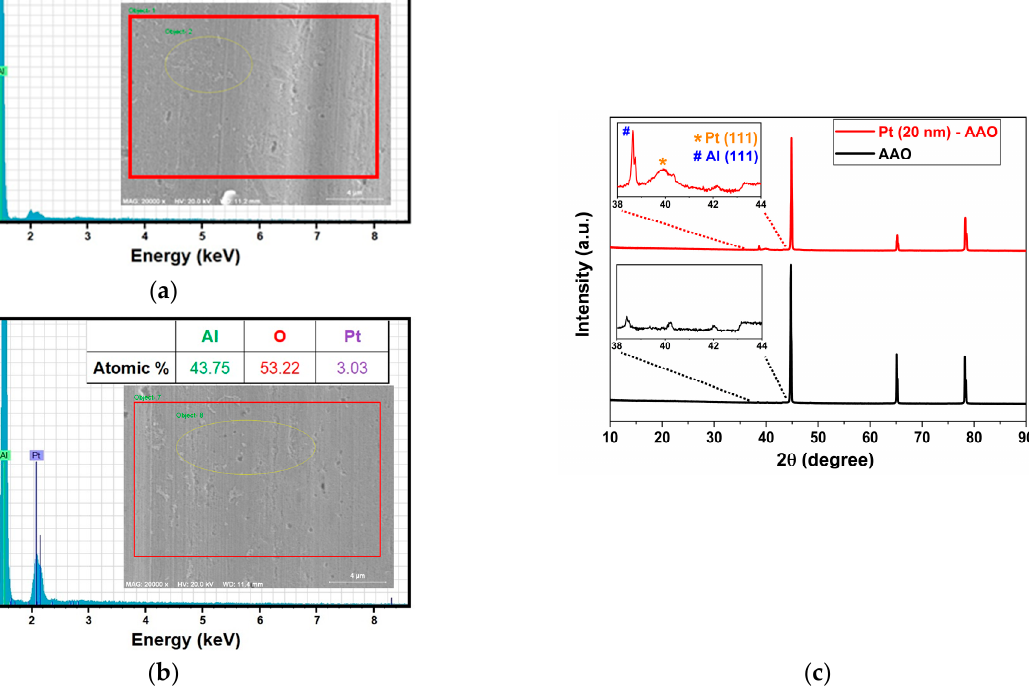
Figure 3. EDX elemental analysis of ( a ) bare AAO and ( b ) 20 nm Pt-coated AAO NPs. ( c ) XRD comparisons of the same samples.